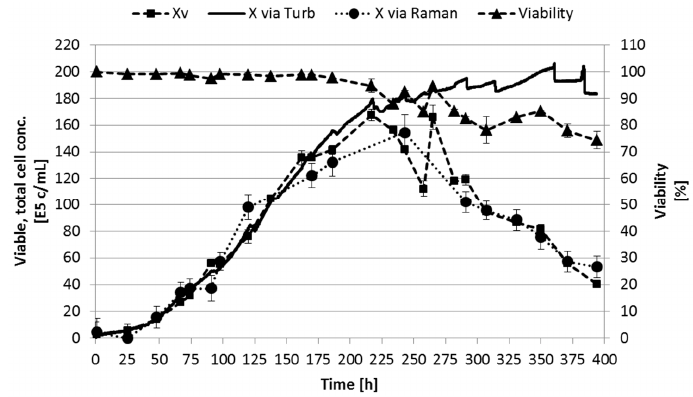
Figure 7. Viable and total cell concentration based on Raman spectroscopy coupled to PLS and turbidity, respectively, compared to experimental viable cell concentration. Error bars represent the double determination of cell concentration and viability, as well as the model error of PLS (RMSE ≤ 13.82).